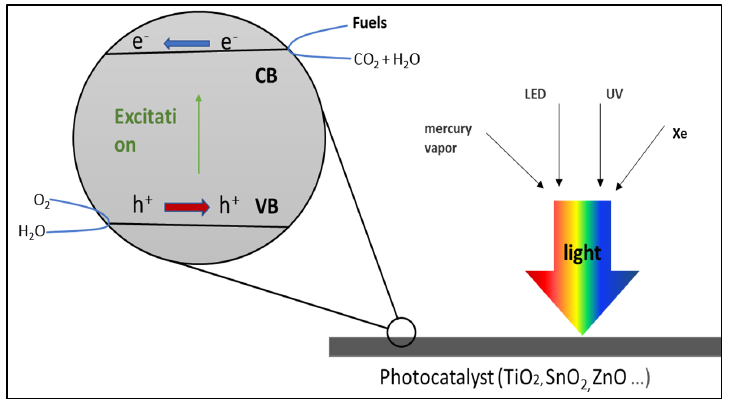
Figure 9. Schematic illustration of photoreduction of CO 2 into fuels on the photocatalyst.